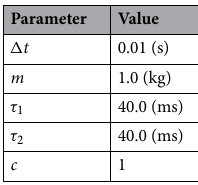
Table 1. Parameters of the movement dynamic system.